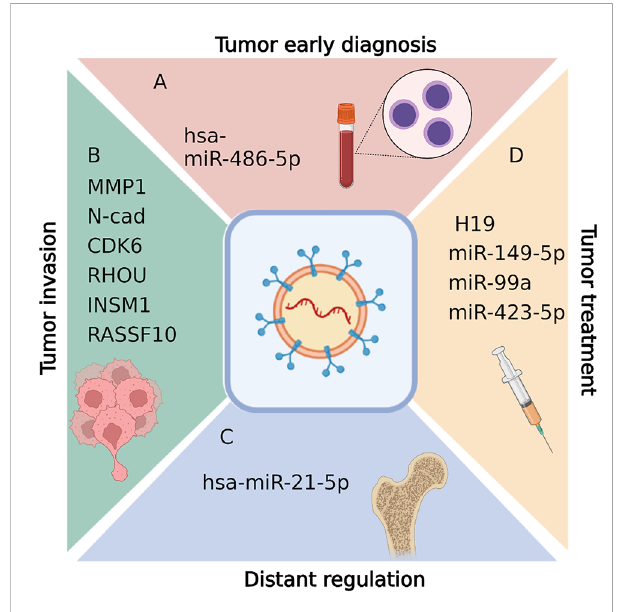
FIGURE 3 Biological functions of exosomal RNAs in pituitary adenomas, including tumor early diagnosis (A) , tumor invasion diagnosis (B) , distant regulation (C) , and tumor treatment (D) . Figures are created in